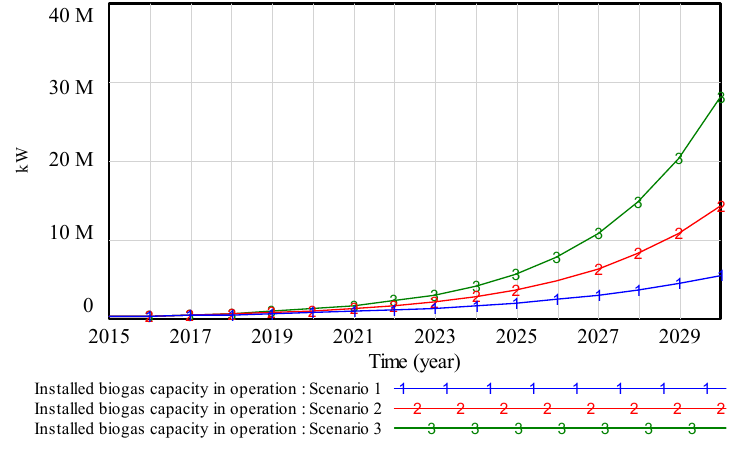
Figure 2. The installed biogas capacity in operation.